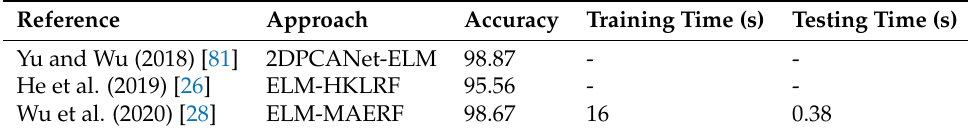
Table 16. The results obtained by CELM architectures for face recognition in YALE